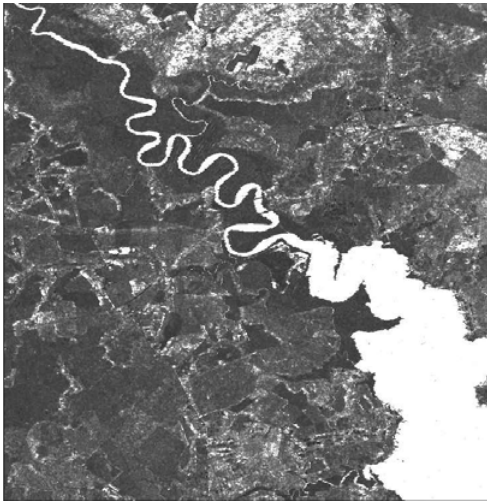
Figure 13: Subset tile N34W78, height error map